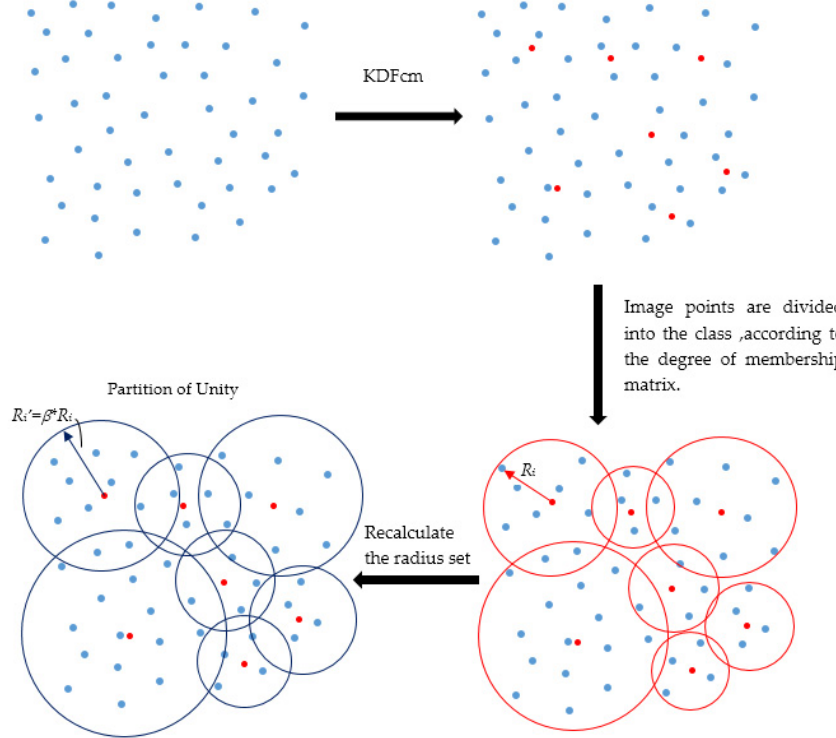
Figure 1. The partition of unity process. In the figure, KDFcm is the abbreviation of fuzzy c-means clustering based on kernel distance.